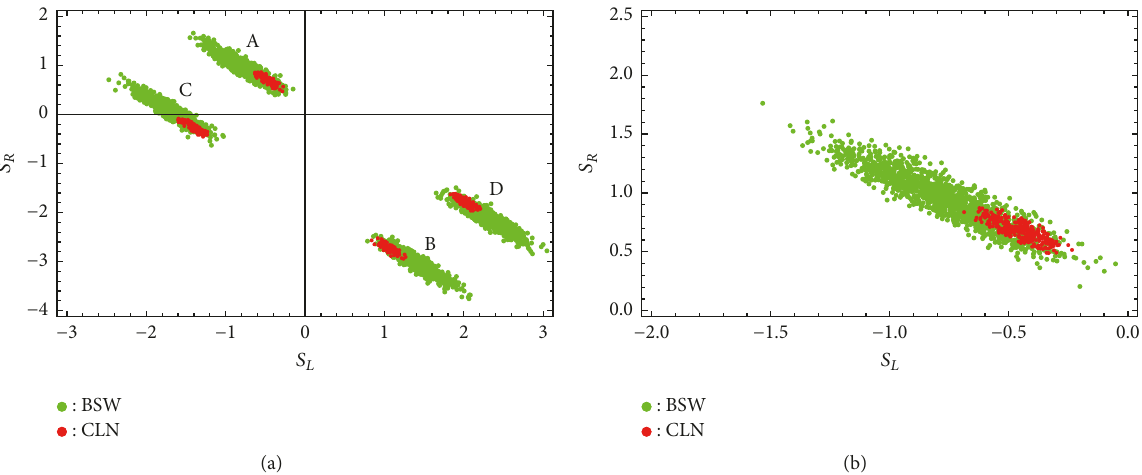
Figure 3: The allowed spaces of 𝑆 𝐿 and 𝑆 𝑅 obtained by fitting to the data of 𝑅 𝐷 and 𝑅 𝐷 ∗ . The other captions are the same as in Figure 1. Table 1: The theoretical predictions for the branching fractions of 𝐵 error is caused by the uncertainties of form factors, CKM factors, and Γ 𝑡𝑜𝑡 (𝐵 ∗ ) ; and the second error given in the last two columns is caused by the NP